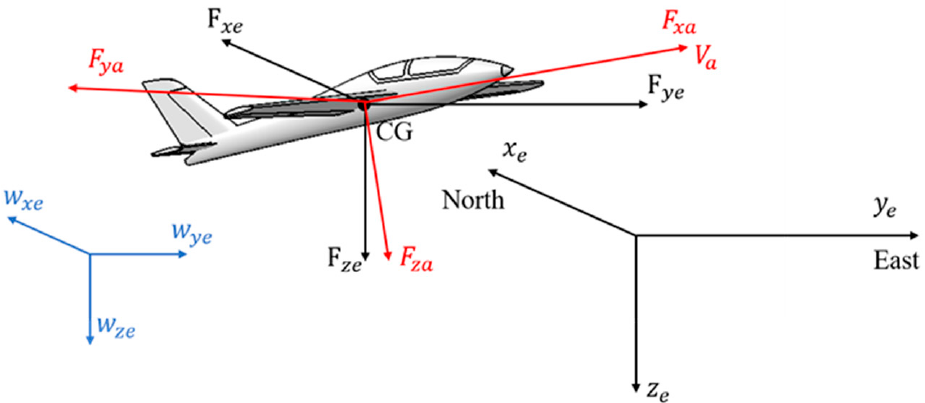
Figure 1. The three axes system this paper used. ( a ) North-East-Down (NED) axes system; ( b ) Body axes system; ( c ) Wind axes system.